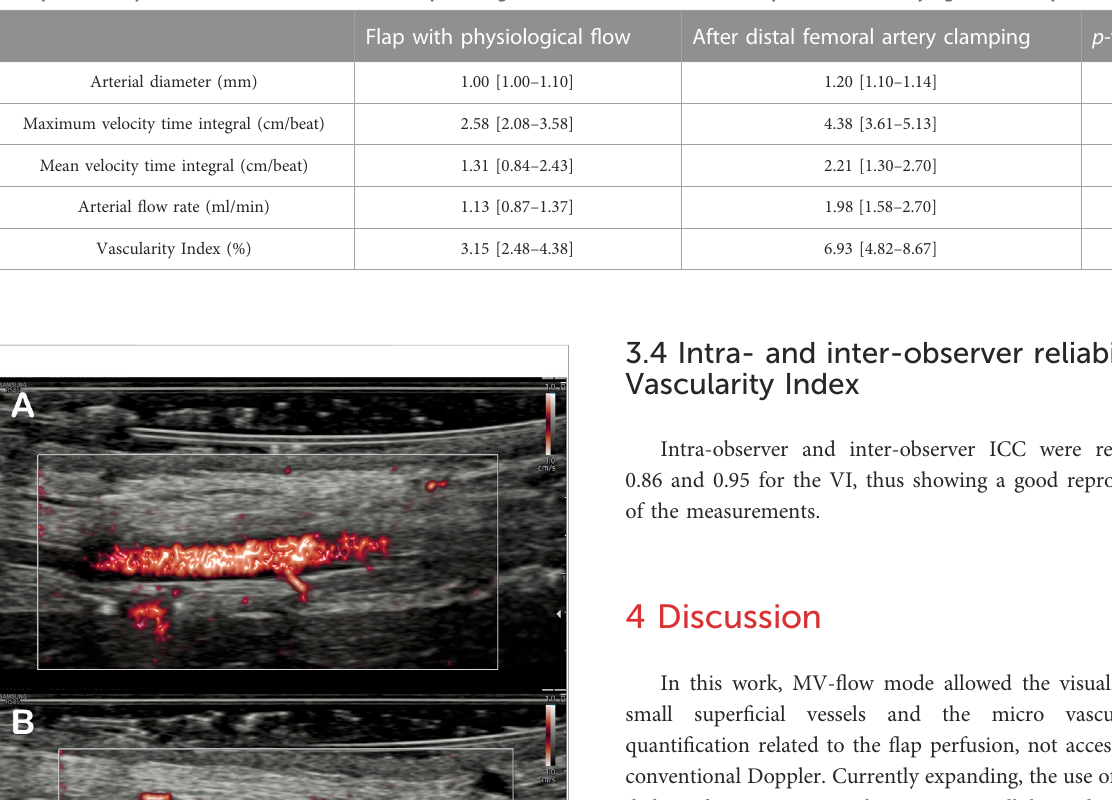
TABLE 1 Hemodynamic analysis of the fl ap before (physiological fl ow) and after clamping the distal femoral artery. Results are presented as median [25th- 75th] percentiles. p -values are obtained from Wilcoxon paired signed-rank test. Data in bold correspond to statistically signi fi cant comparisons ( P < 0.05).